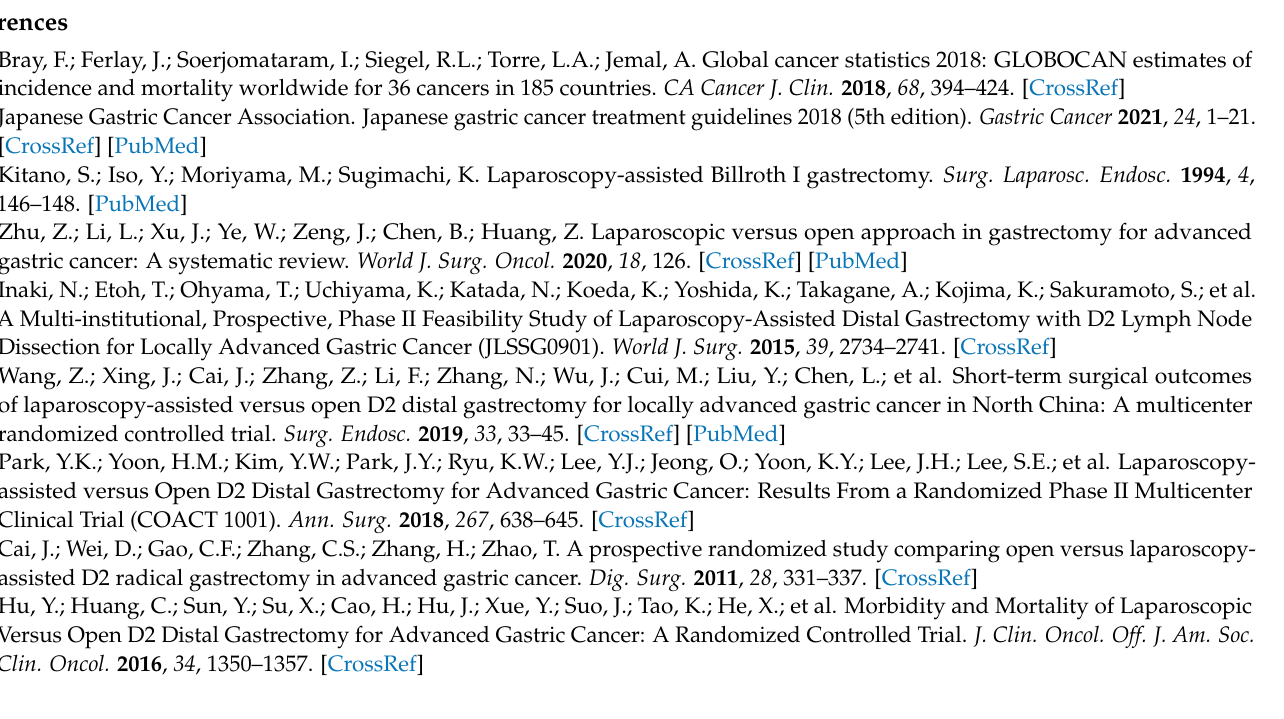
Table S3: In hospital complications in the entire